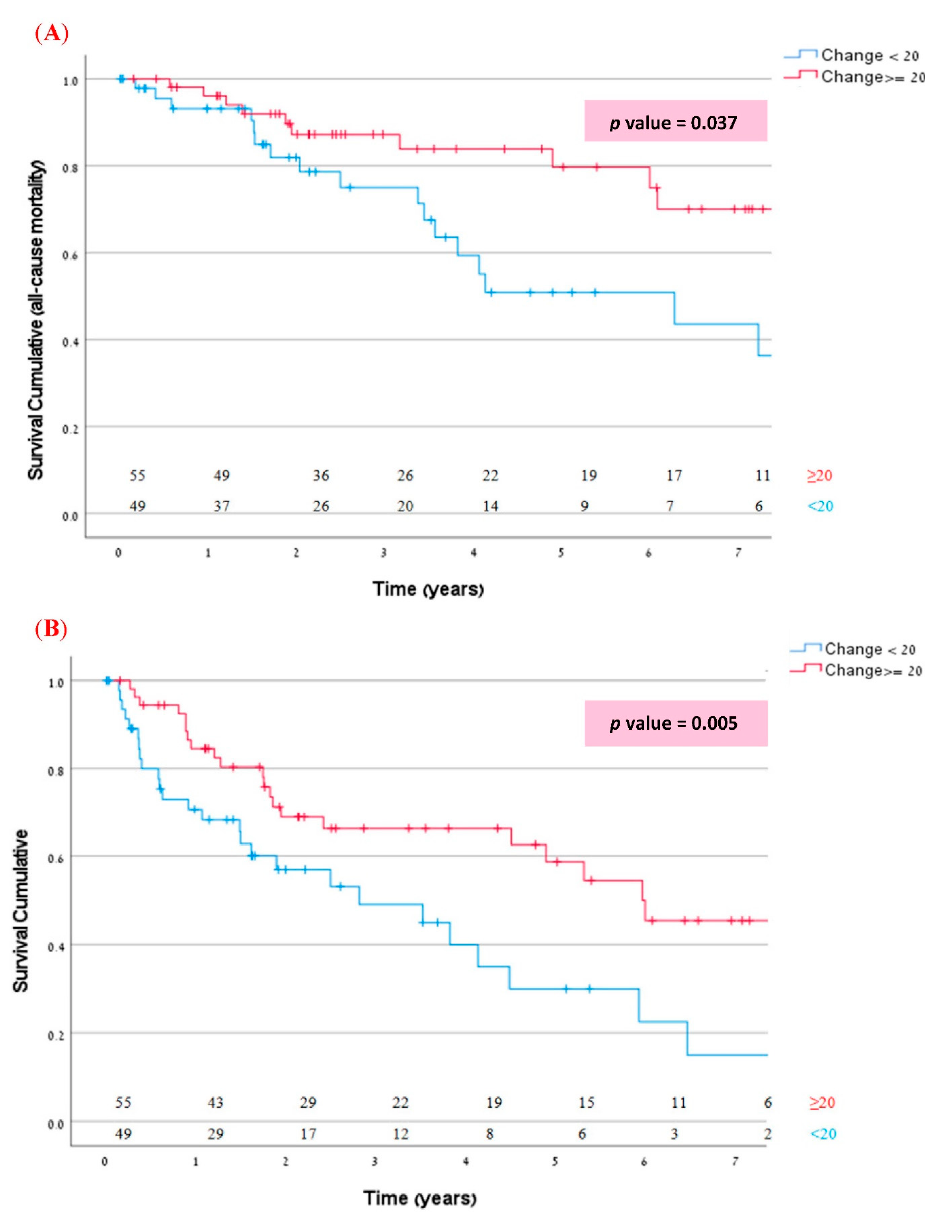
Figure 3. Kaplan-Meir curves for ( A ) mortality and ( B ) Composite of all-cause mortality or HF hospitalization among patients with/without acute QRS narrowing ≥ 20 ms.